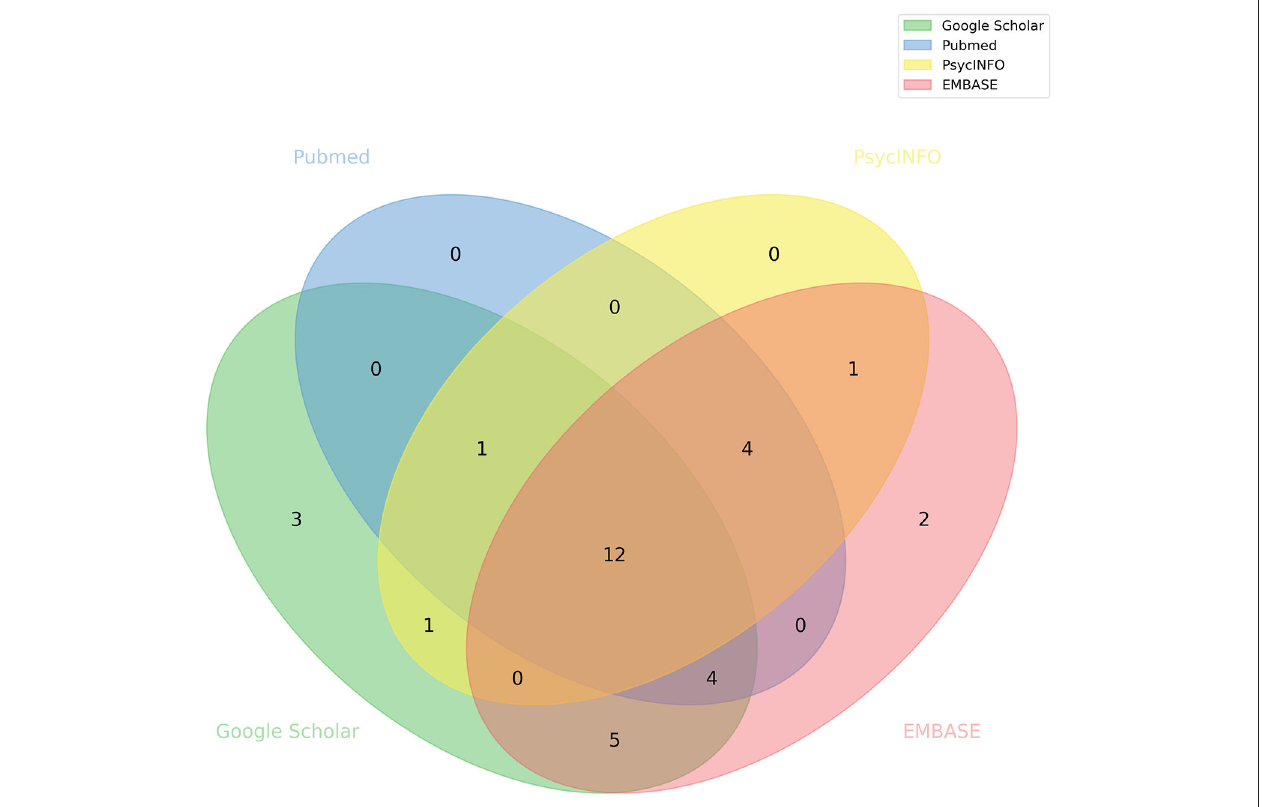
FIGURE 2 | Database source of articles included in this systematic review. Venn diagram illustrating the overlap between studies obtained from different